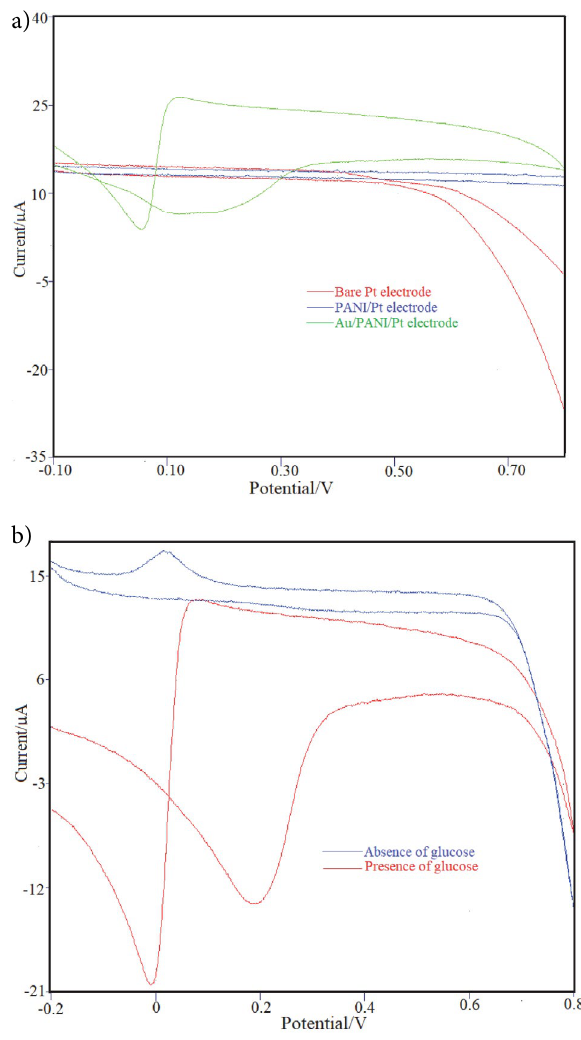
Figure 6. (a) CVs of bare Pt electrode, PANI/Pt electrode, and Au/ PANI/Pt electrode towards oxidation of 1 mM glucose in 0.1 M